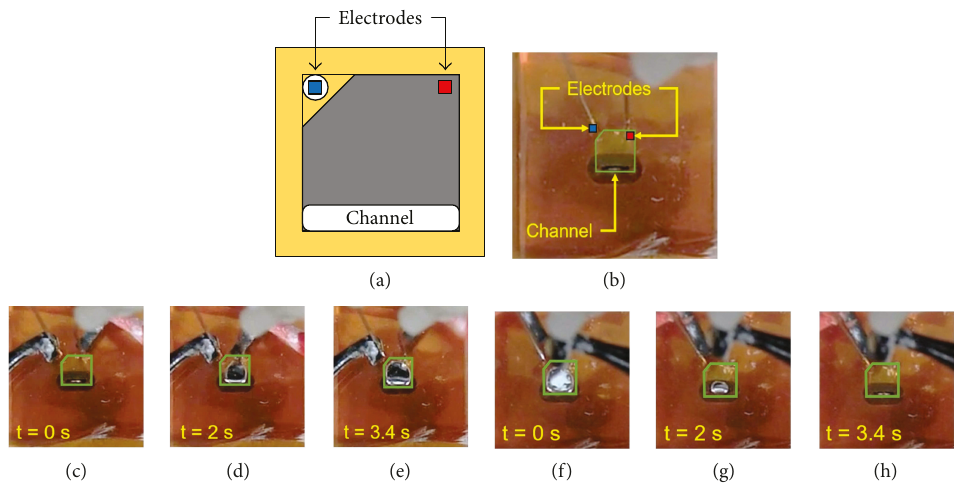
Figure 3: (a) Layout of the prototype pixel bottom side with an actuation circuit. (b) Fabricated pixel with an outlined pixel and electrodes. Stainless-steel syringes (not shown) are used to puncture the PDMS. (c) Application of 1.2V to actuate liquid metal from a reservoir buried below. (d) Liquid metal actuating. (e) Completion of liquid-metal actuation. (f) Swapping voltage applied to electrodes. (g) Liquid metal retreats to the reservoir below. (h) Completion of liquid-metal actuation. Table 1: Measured versus simulated resonance frequencies. “ On ” pixels (per arm) 1 2 3 4 Measured (GHz) Simulated (GHz)